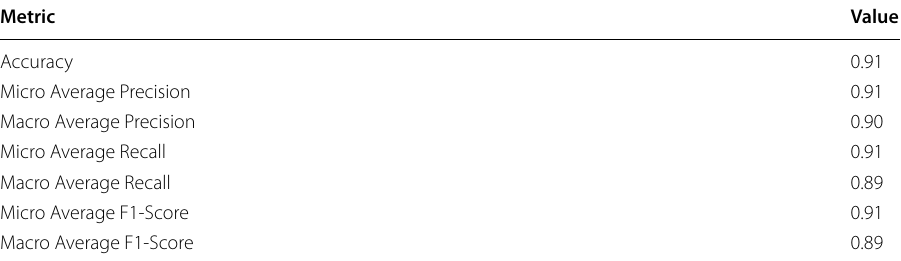
Table 17 Values of some quality metrics obtained by applying our classification algorithm with our version of the Eros